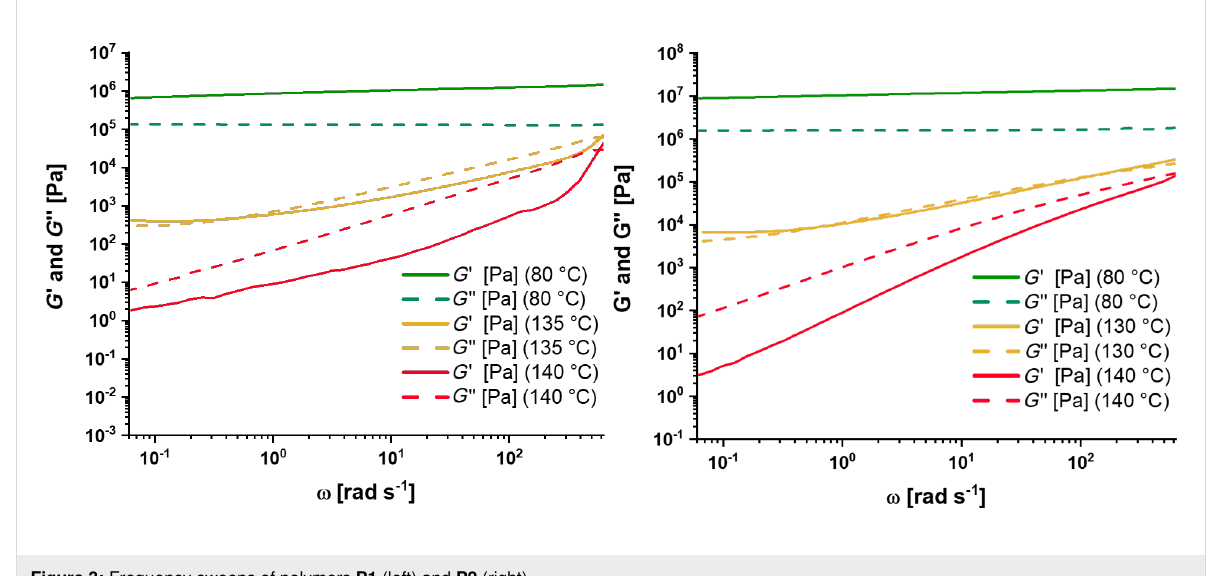
Figure 3: Frequency sweeps of polymers P1 (left) and P2 (right).